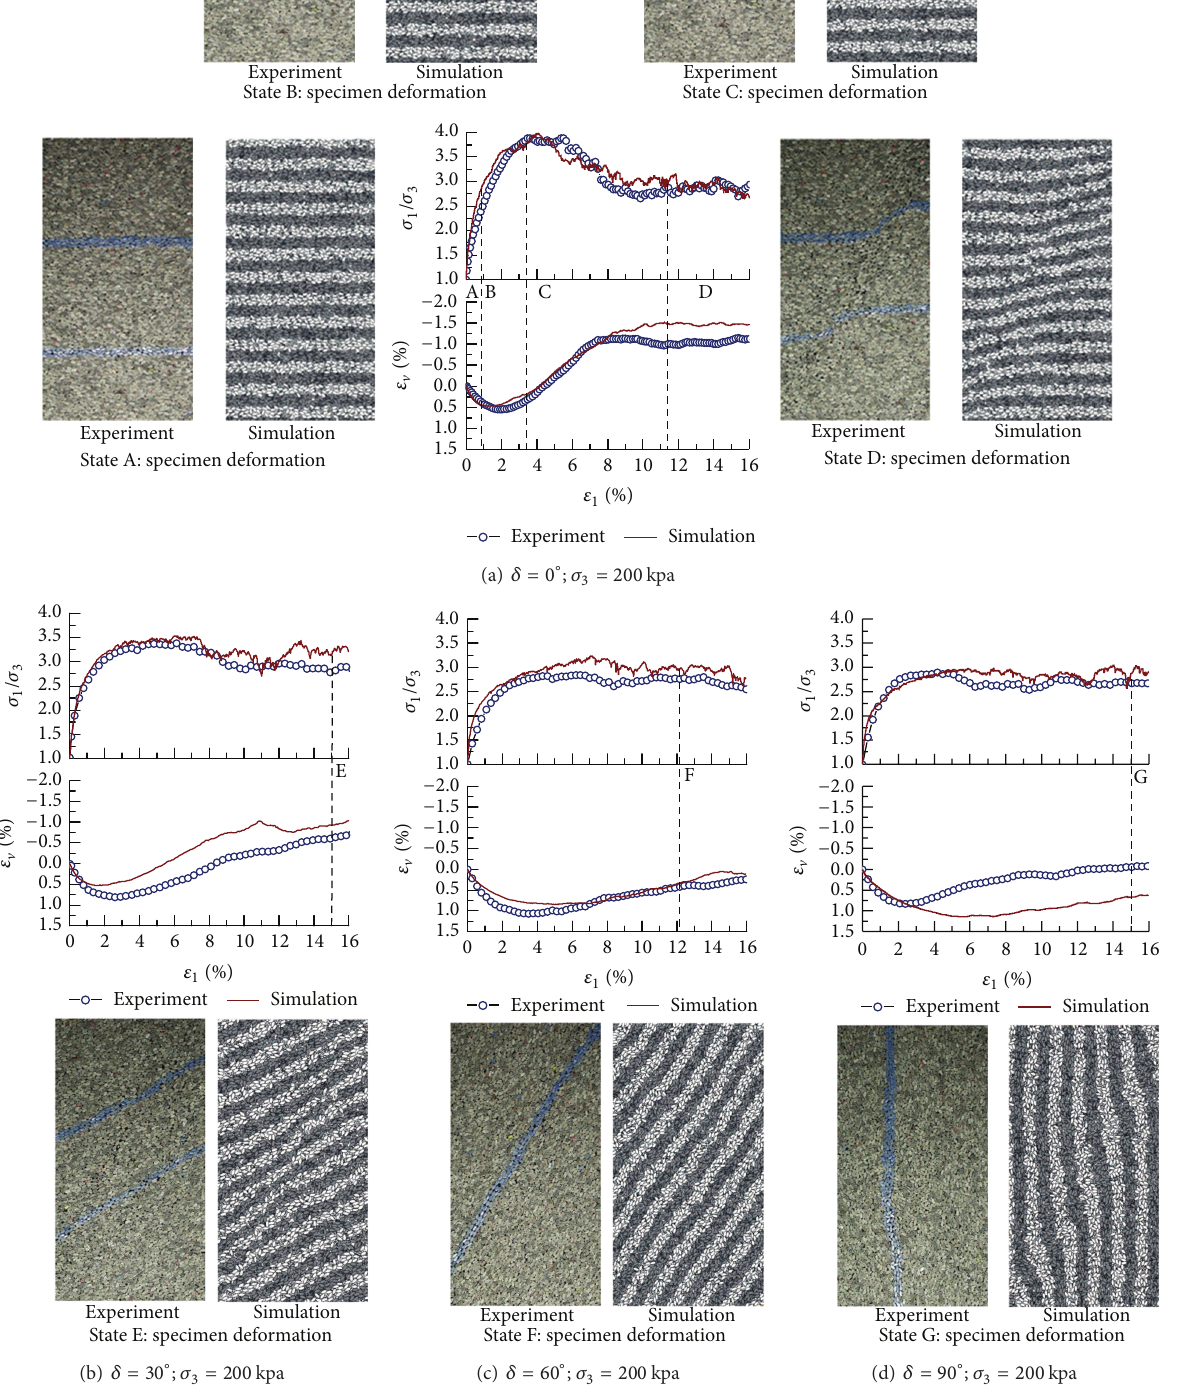
Figure 4: Stress-strain relationship and deformation comparison between experiments and simulations at different tilting angles: (a) 𝛿 = 0 ∘ , (b) 𝛿 = 30 ∘ , (c) 𝛿 = 60 ∘ , and (d) 𝛿 = 90 ∘